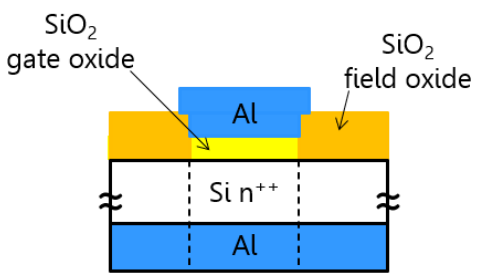
Figure 1. Cross-view of the investigated Al/SiO 2 /n ++ -Si device (not to scale).